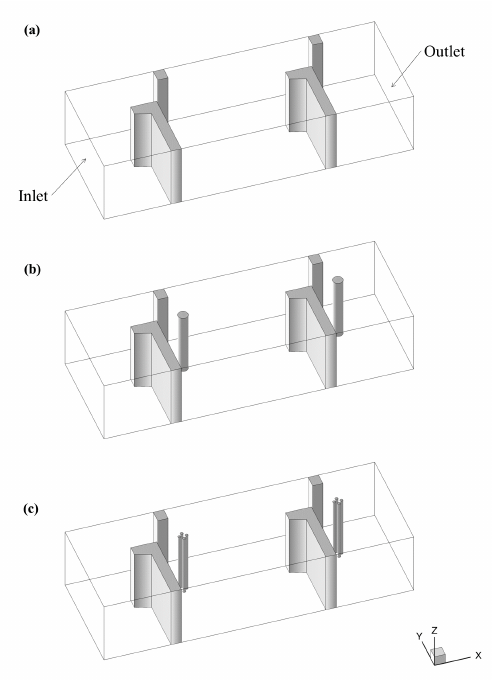
Figure 2. A 3D view of the computation domains with obstacles of three cases. ( a ) Case 1: original design; ( b ) Case 2: an isolated cylinder in each pool; ( c ) Case 3: four cylinders in each pool. Table 1. Hydraulic conditions and computational